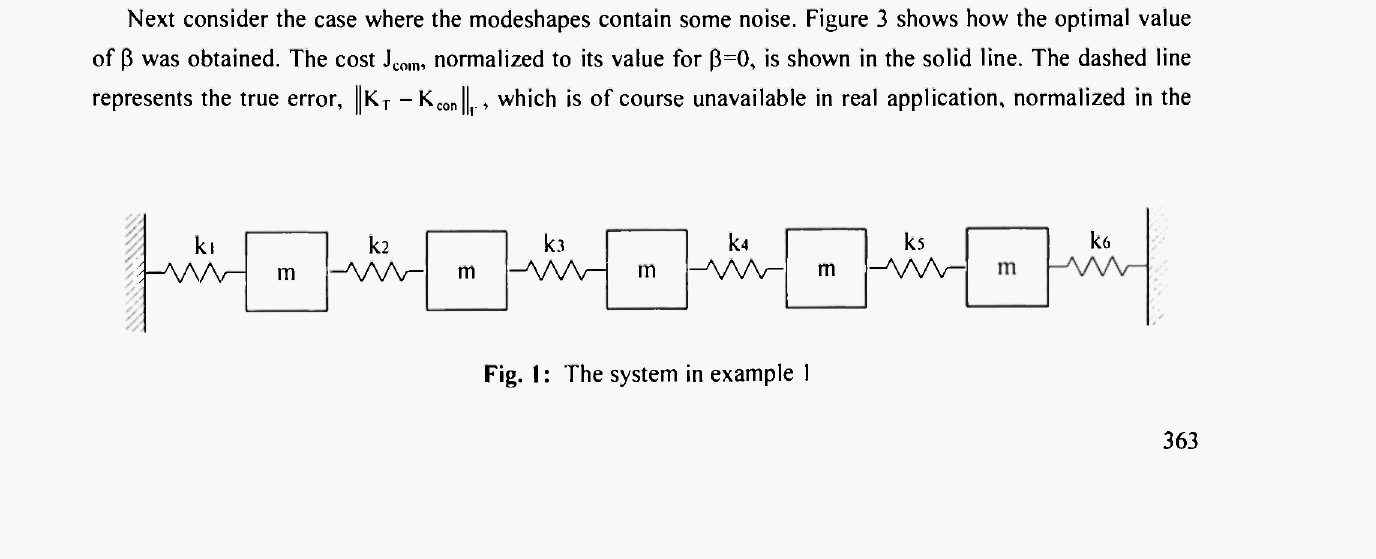
Fig. 1 : The system in example